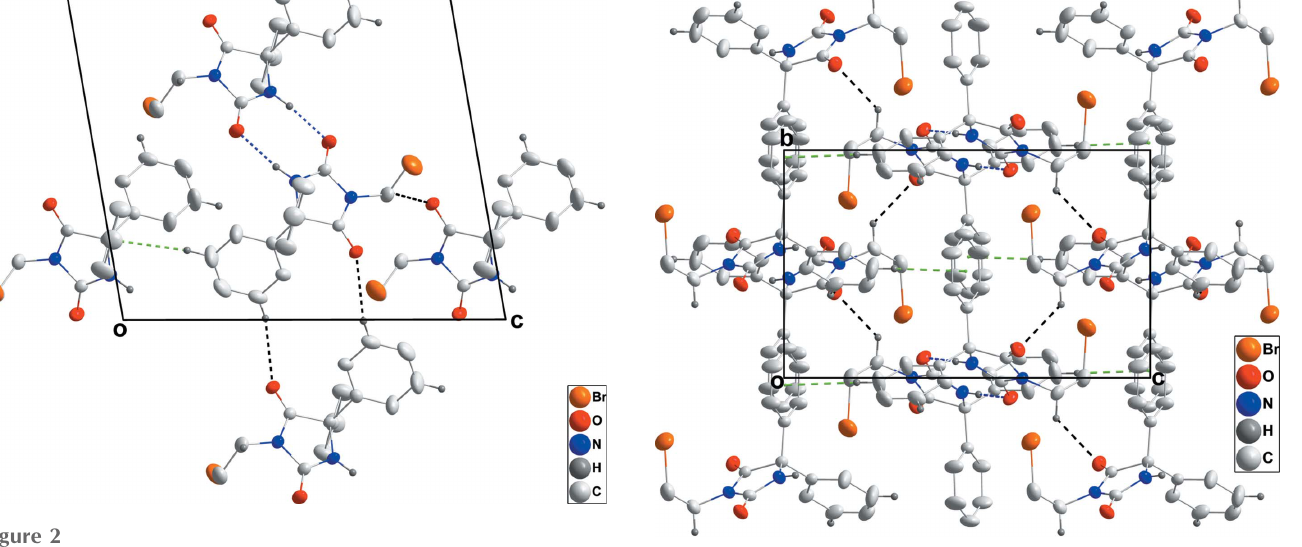
Figure 2 Detail of the intermolecular interactions viewed along the b -axis direction. N—H (cid:3)(cid:3)(cid:3) O and C—H (cid:3)(cid:3)(cid:3) O hydrogen bonds are shown, respectively, by blue and black dashed lines, while the C—H (cid:3)(cid:3)(cid:3) (cid:2) (ring) interactions are shown by green dashed lines.